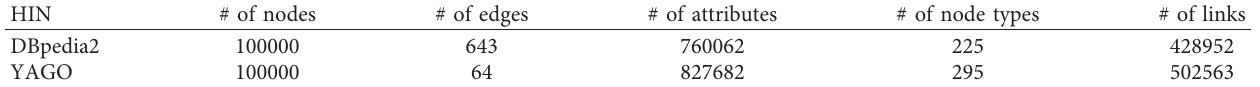
Table 2: Statistics of HINs constructed based on DBpedia and YAGO.